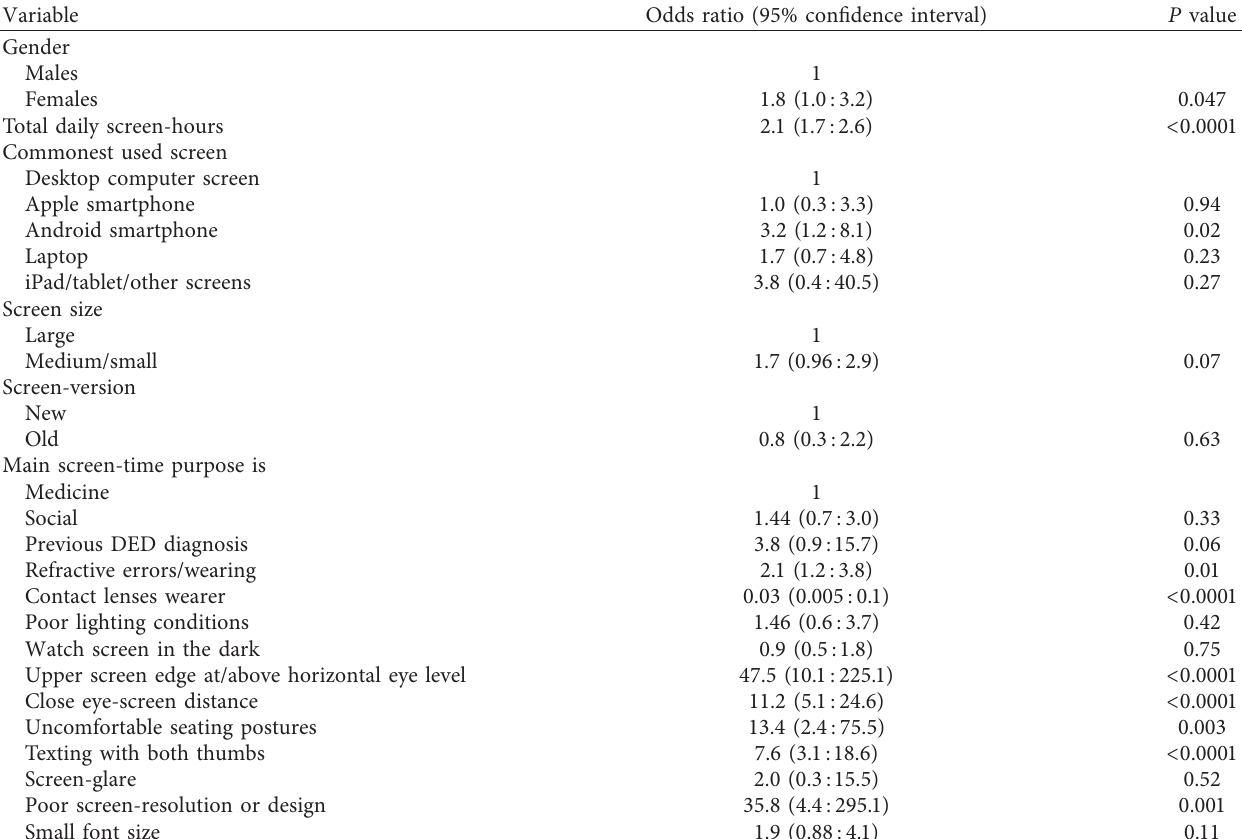
Table 3: Multivariate logistic regression analysis model of factors affecting the occurrence of computer vision syndrome. Variable